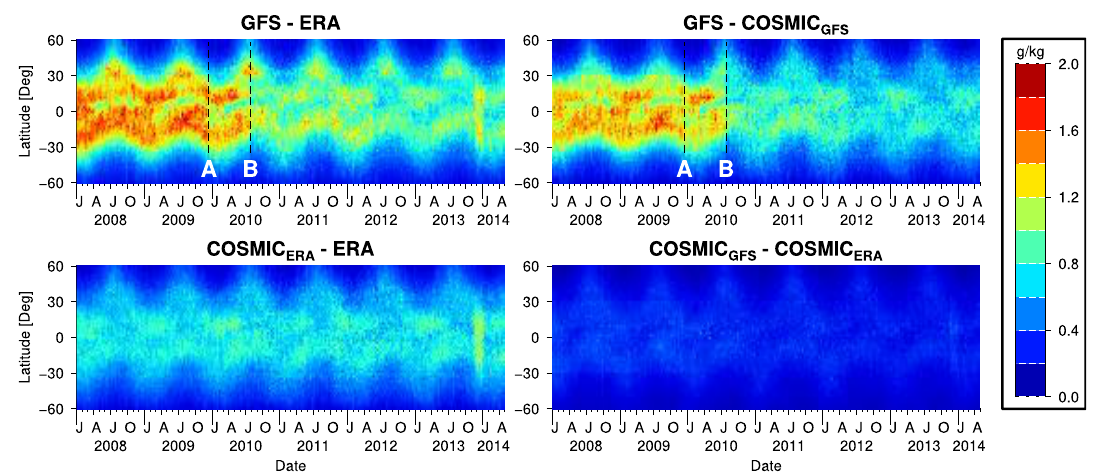
Figure 12. Root-mean-square differences of 2.5 km specific humidity (g kg −1 ) among the operational NCEP analysis (denoted GFS), the ECMWF Interim reanalysis (denoted ERA), and two 1D-Var retrievals (denoted COSMIC GFS and COSMIC ERA ) for each of which GFS and ERA are used as a priori data, for the period from January 2008 to August 2014. The dashed lines in upper panels, denoted A and B, coincide with the times that NCEP GFS underwent major system upgrades. See text for details.